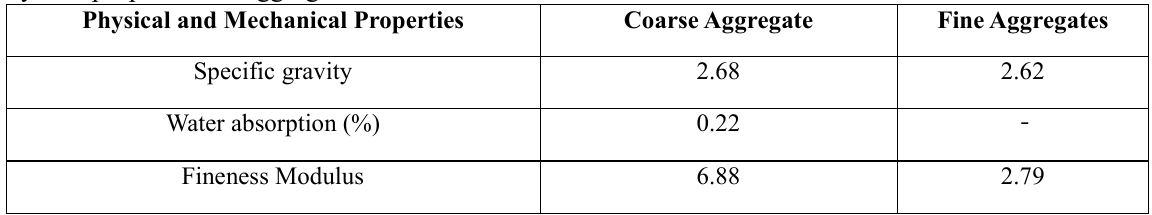
Physical properties of Aggregate Materials. Physical and Mechanical